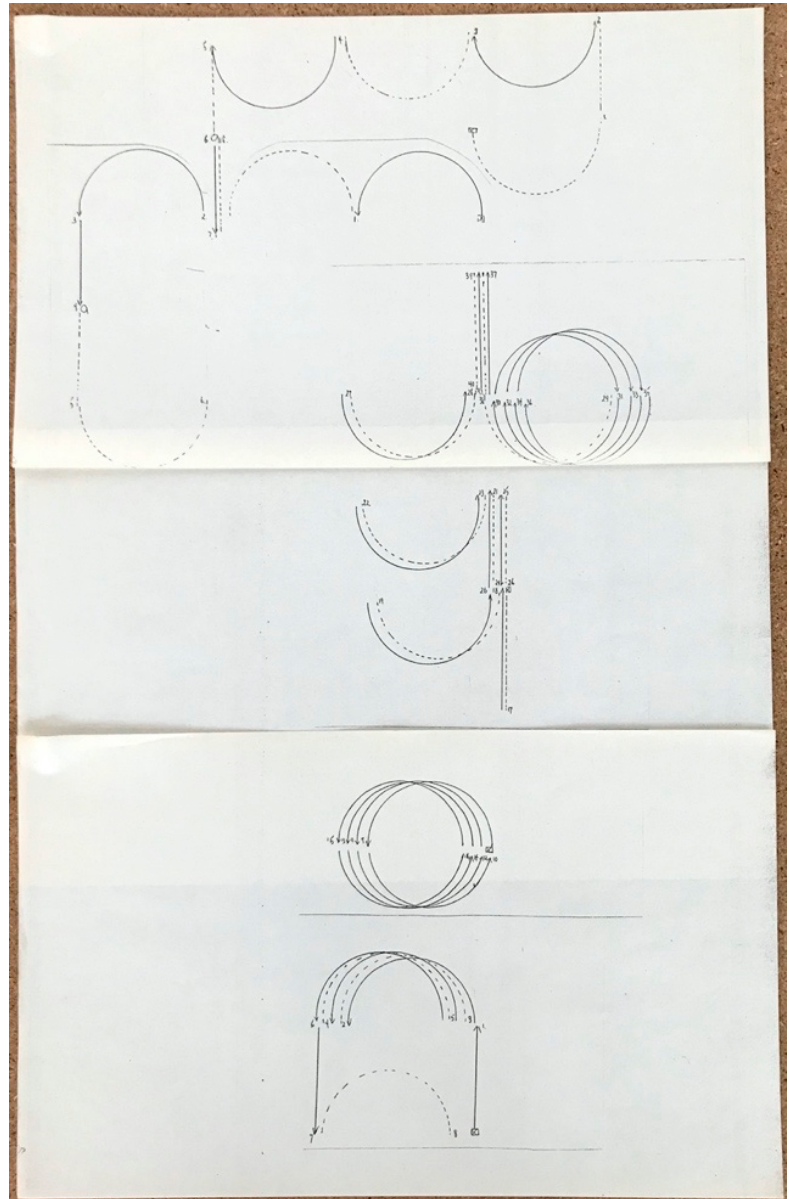
Figure 7. Lucinda Childs, master score for dancer 3, Calico Mingling (1973), photocopy, 10.5” × 10½”, Fonds Lucinda Childs—Médiathèque du Centre national de la danse.